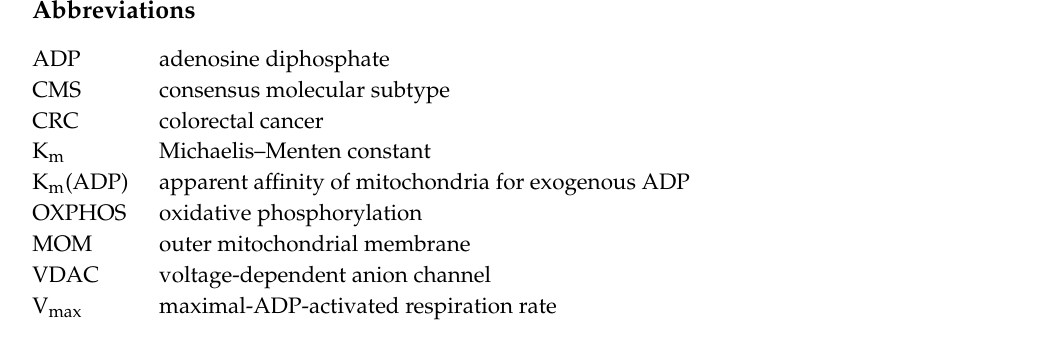
Figure S1: Regulation of mitochondrial respiration in KRAS + , BRAF + and wild-type tumors and controls, Table S1: The maximal ADP-activated respiration rates (Vmax) comparison by molecular groups. Respiration rates are given in nmol O2 / (min × mg dry weight), Table S2: Km comparison by molecular